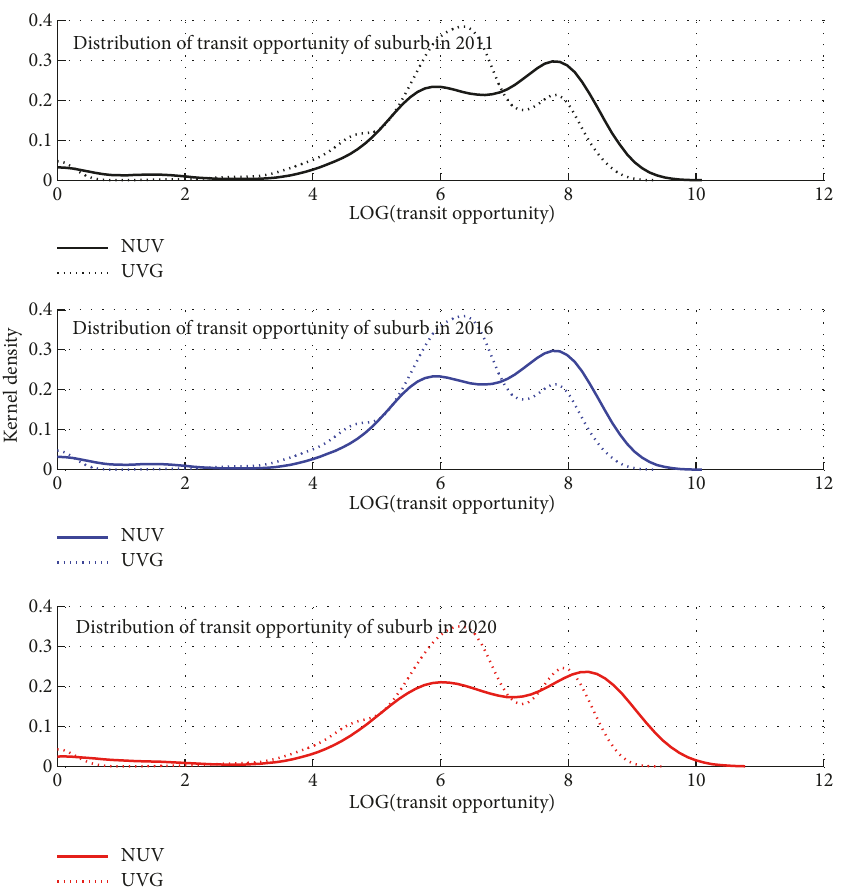
Figure 8: Comparisons of the probability distribution of the two groups in the